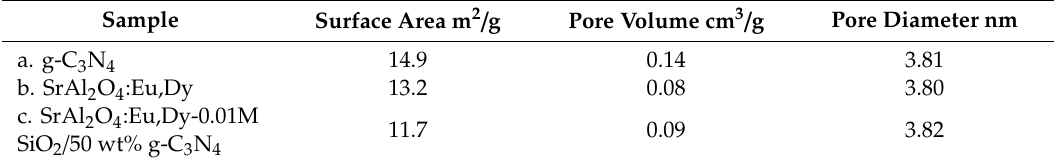
Table 3. BET specific surface area, BJH pore volume and pore diameter for the catalysts. Sample Surface Area m 2 / g Pore Volume cm 3 /